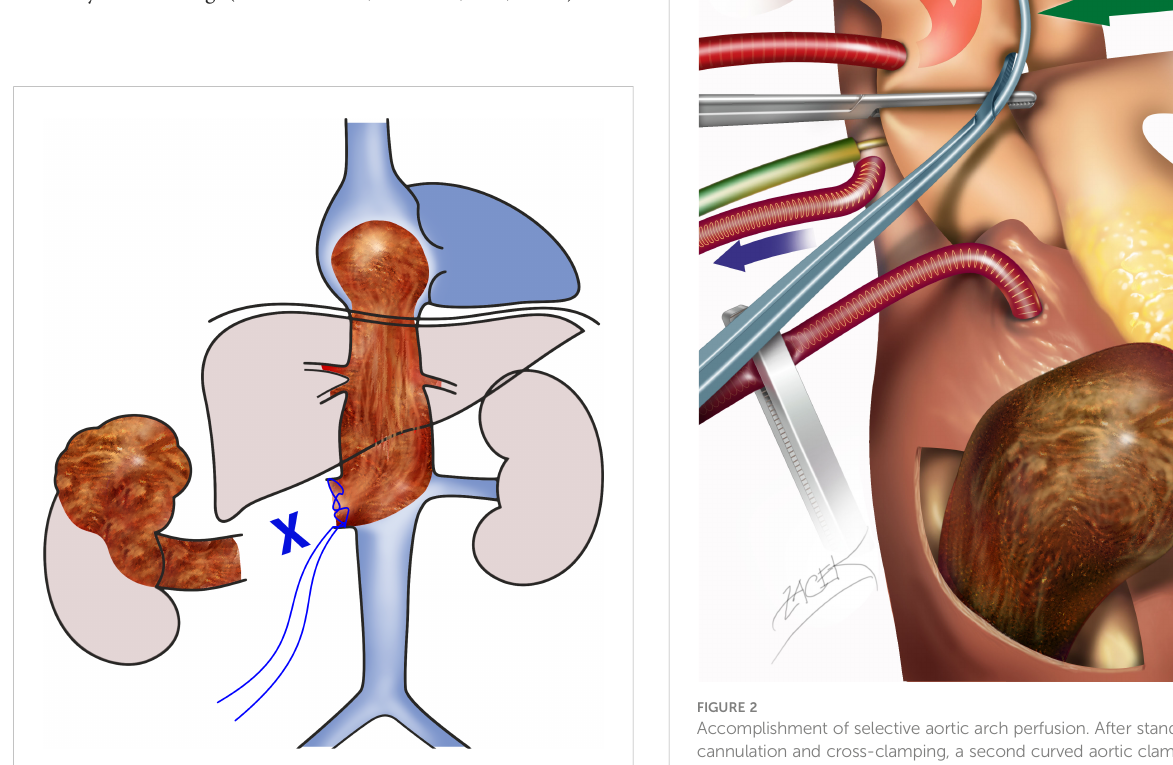
FIGURE 1 Scheme of the 1st phase of the surgery. The right kidney with a tumor was already removed, and level IV intracardiac tumor thrombus was secured in place by suturing the stump of the right renal vein.